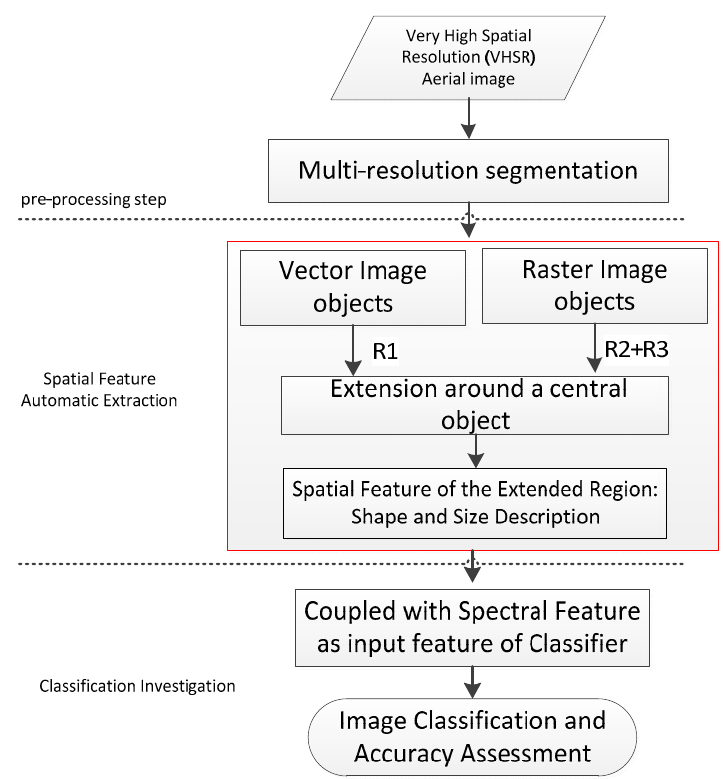
Figure 2. Schematic of proposed Tobler’s First Law of Geography (TFL)-based classification method.